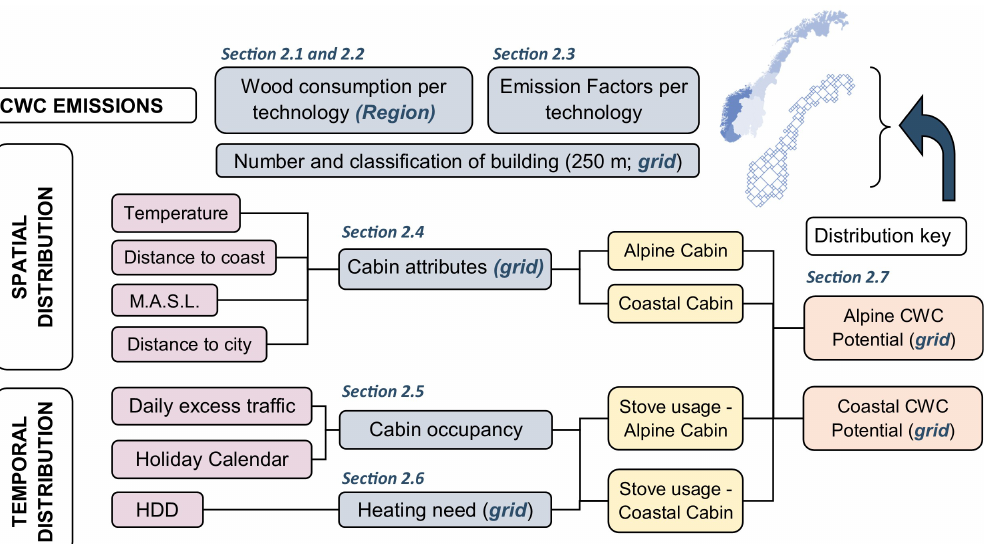
Figure 1. Diagram of the overall methodology and input data used to estimate CWC emissions and distribute them at high spatio-temporal resolution. The scheme shows the sections in this manuscript where each part is described in